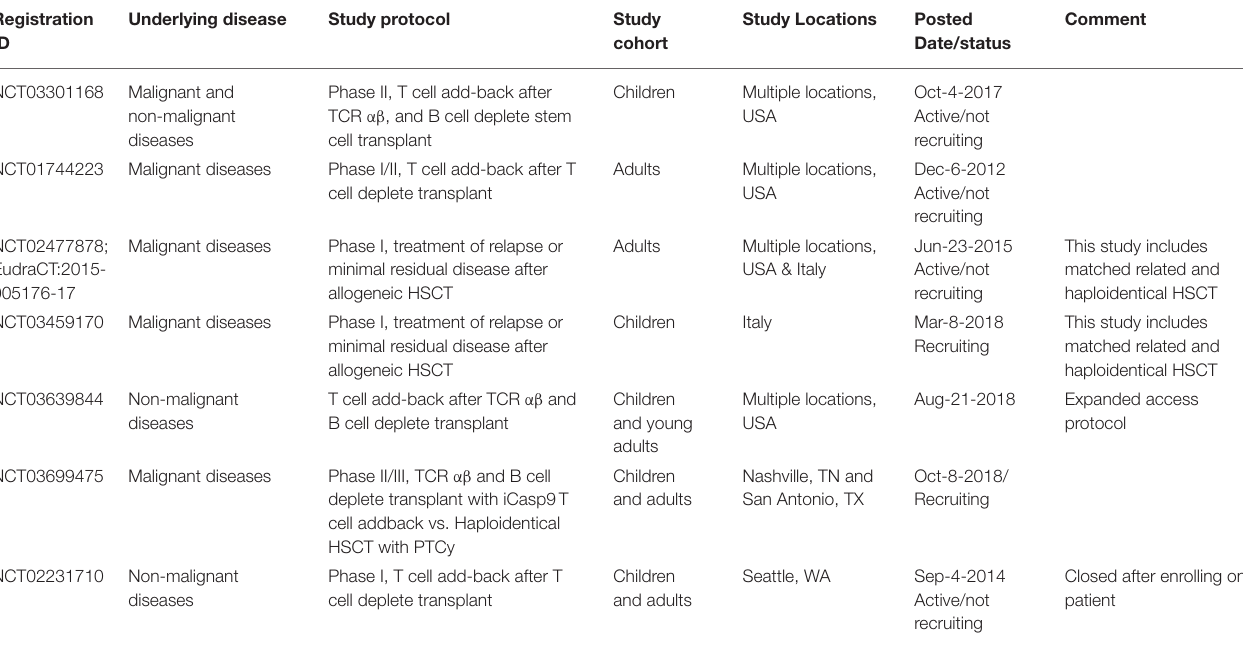
TABLE 5 | Additional clinical trials on ClinicalTrials.gov involving iCasp9T cell addback following haploidentical HSCT *